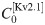
State transition diagram of the Markov model for the Kv2.1 channel.
C0[Kv2.1]–C4[Kv2.1] are the closed states; O[Kv2.1] is the open state, and I0[Kv2.1]–I5[Kv2.1] are the inactivation states; kv[Kv2.1], k-v[Kv2.1], k1[Kv2.1], k−1[Kv2.1], k0[Kv2.1], and k−0[Kv2.1] denote transition rates between the states.